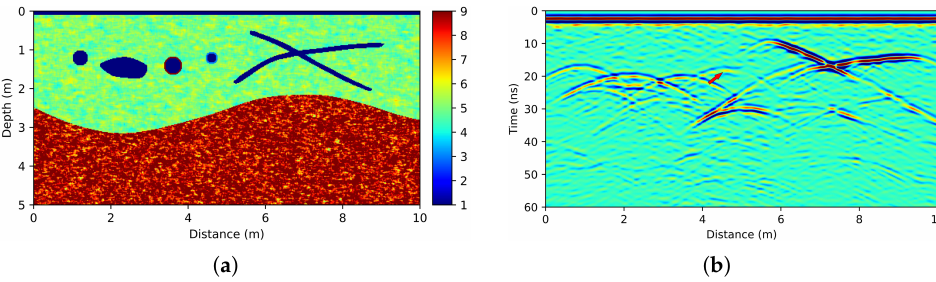
Figure 9. Synthesis of the stochastic media model and the corresponding GPR recordings. ( a ) Relative dielectric constant model with stochastic media; ( b ) corresponding GPR recordings.